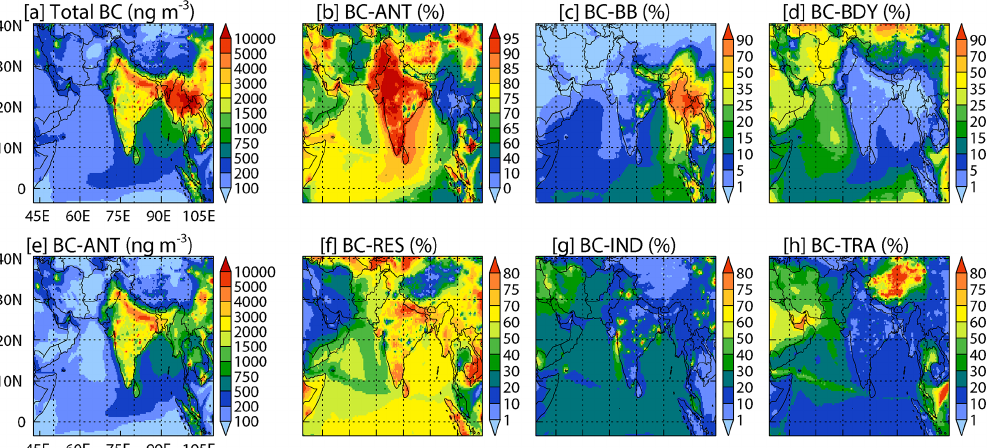
Figure 5. Spatial distributions of (a) total BC and (e) total anthropogenic BC mass concentration averaged over the ICARB period. Percentage contributions of BC-ANT (b) , BC-BB (c) and BC-BDY to total BC and BC-RES (f) , BC-IND (g) and BC-TRA (h) to total anthropogenic